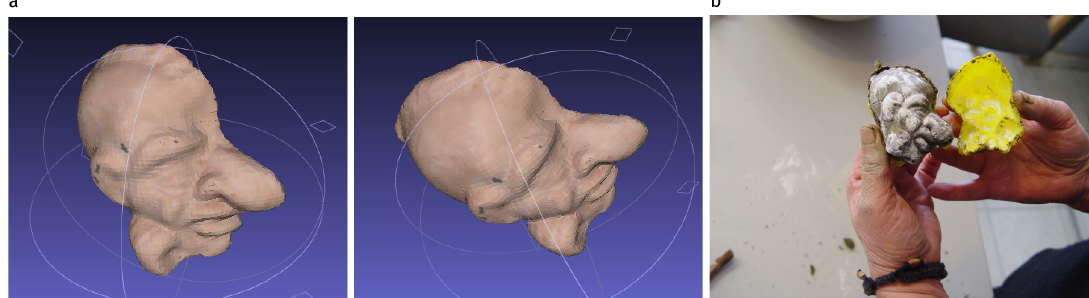
Figure 1: ( a ) Smoothing surfaces for the creation of copies and new moulds (both 3D and physical). ( b ) Using a 3D-printed mould to reproduce a copy of a terracotta